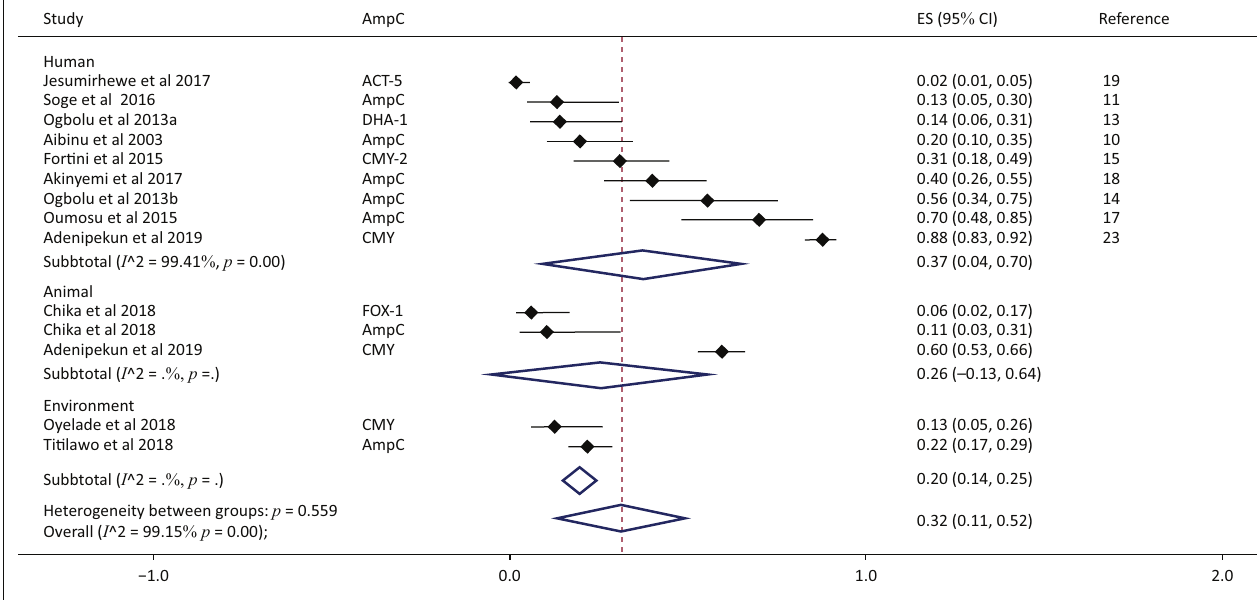
Study AmpC ES (95 % CI)